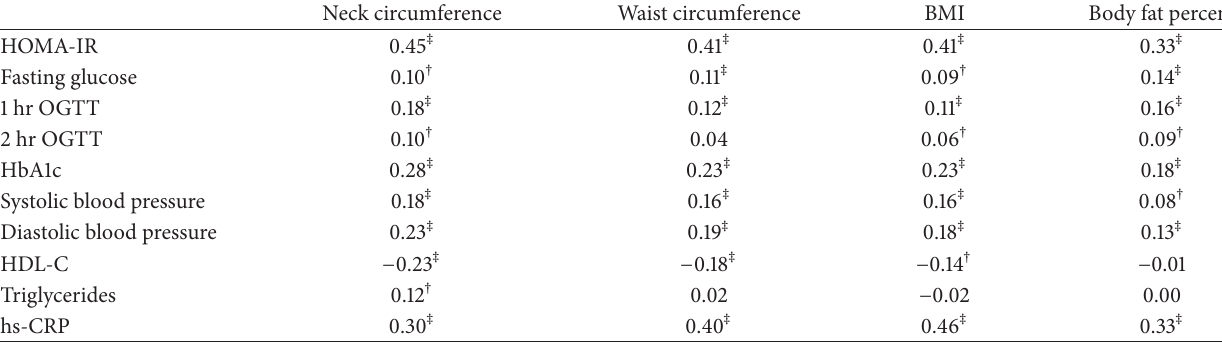
Table 3: Pearson’s partial correlations of anthropometric measurements with metabolic factors ∗ .